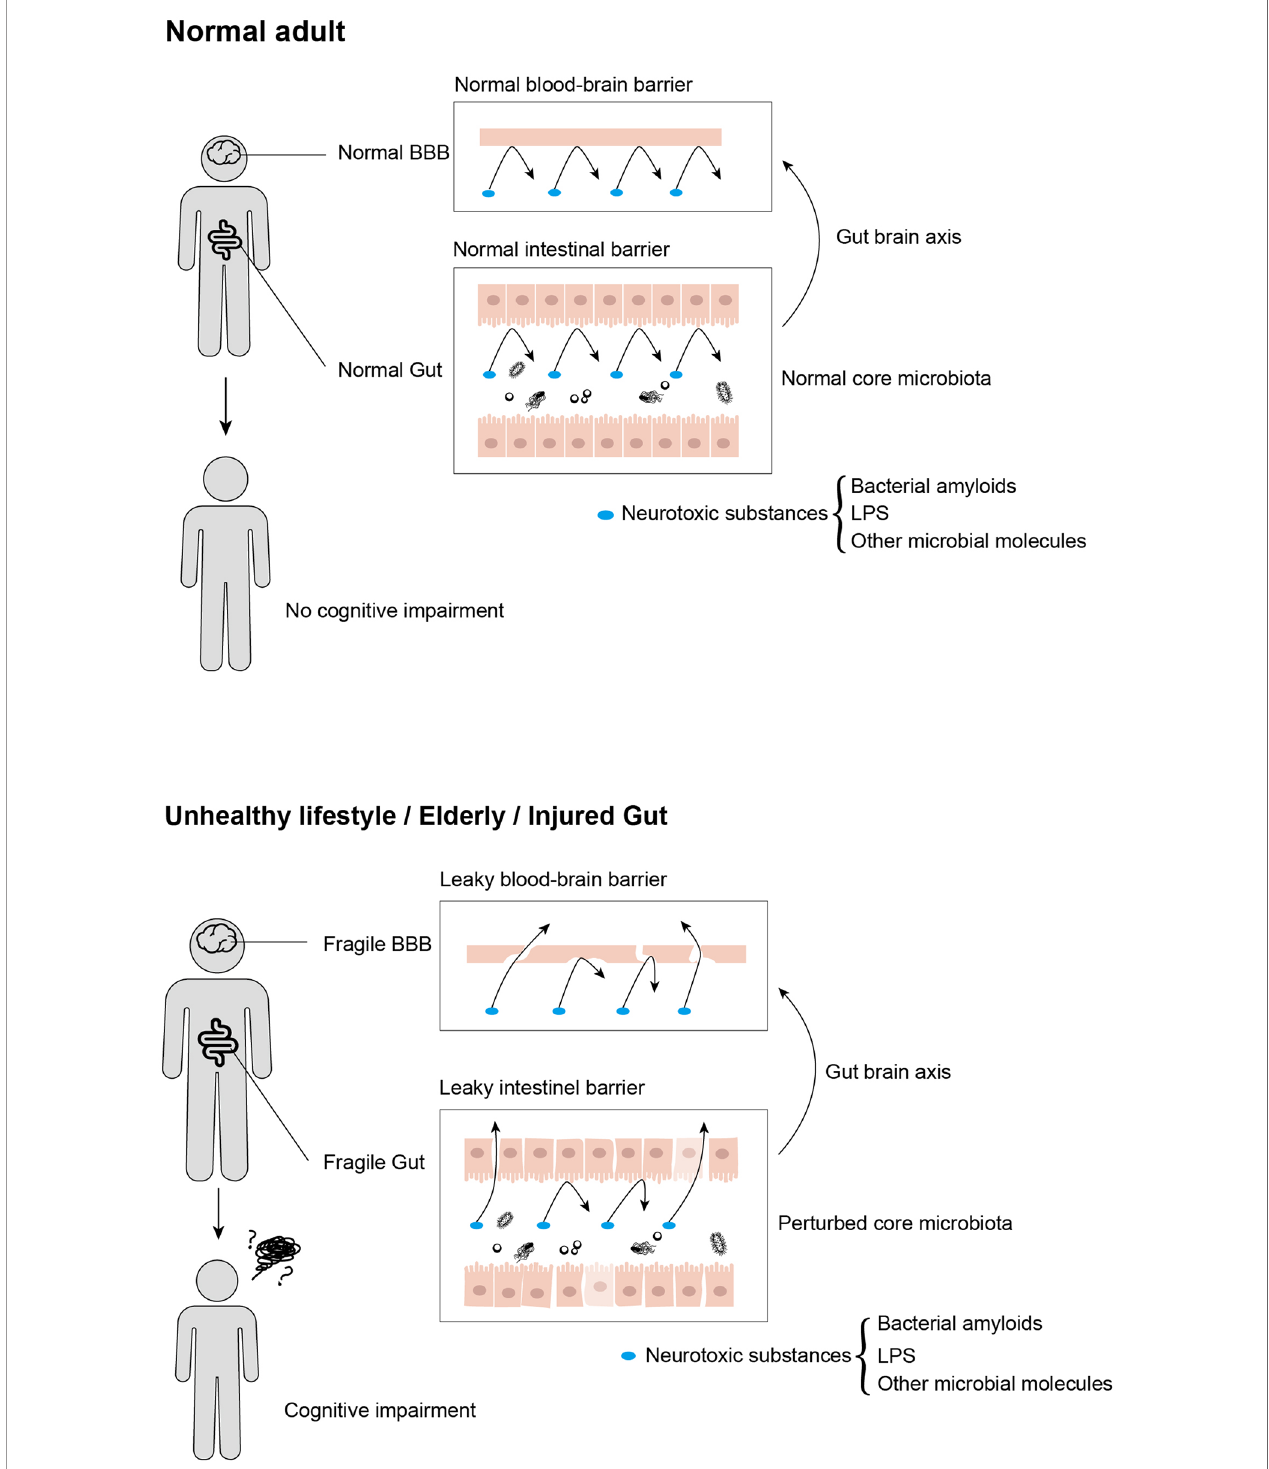
FIGURE 2 | Neurotoxic substances that are produced by gut microbiota in fl uence cognitive impairment progression by transmitting from gut to brain, in which intestinal barrier and blood – brain barrier served as crucial customs passes. Moreover, these neurotoxic substances cannot traverse from usual intestinal and blood – brain barriers, while aging, unhealthy lifestyles, and acute or chronic enteritis would disrupt the integrity of both intestinal and blood – brain barriers, leading to cognitive impairment.